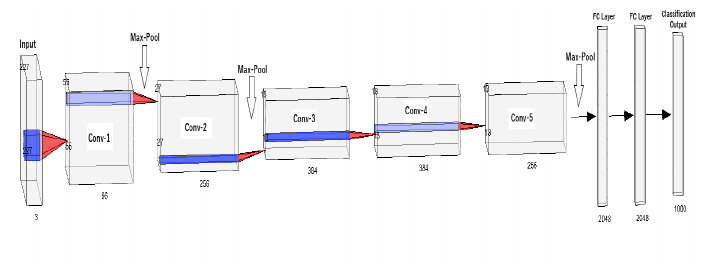
Figure 7. AlexNet